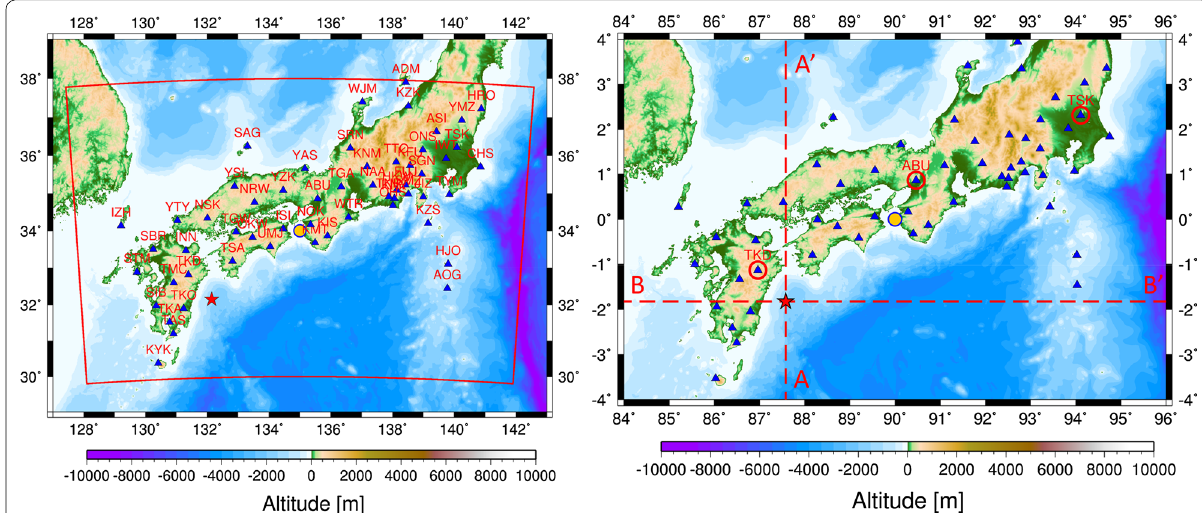
Fig. 8 Left map in original coordinates. Region enclosed by the red line indicates the target area. Right map after converting to ecliptic coordinates. A red star and orange circle indicate the epicenter and the reference point, respectively. Triangles denote the location of F-net seismic stations. Red dashed lines indicate the location of cross sections shown in Fig. 9 for the structure model used in the